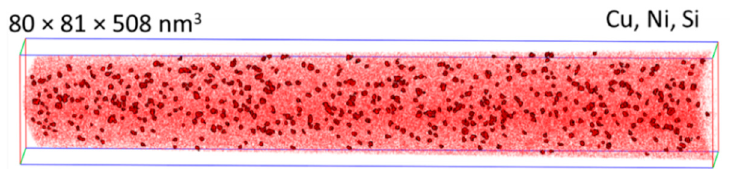
Figure 4. APT solute atom map for the RPV base material irradiated at high flux (BH). Cu, Ni and Si atoms are represented in red. Clusters are highlighted using a threshold of 3.6 at%.